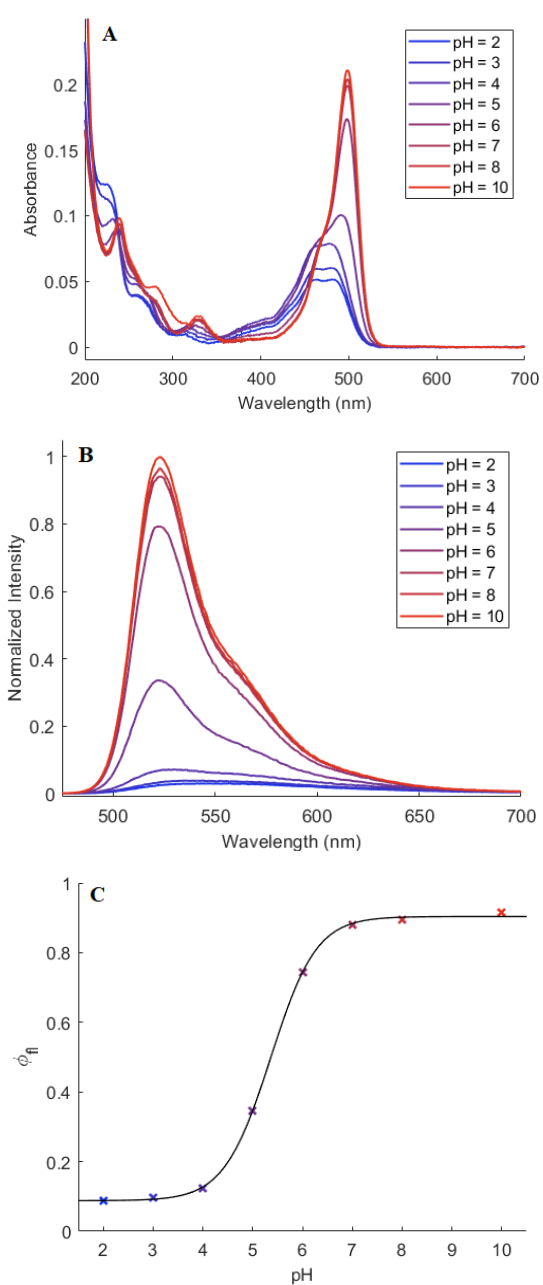
Figure 5. ( A ) Absorption spectra, ( B ) fluorescence spectra, and ( C ) fluorescence quantum yield, φ fl , of Athens Green in H 2 O recorded as a function of pH. For the latter, errors on a given point are approximately 5% of the φ fl magnitude shown. For the fluorescence data, the excitation wavelength was 470 nm, and the spectra in panel B were normalized for pH-dependent changes in the